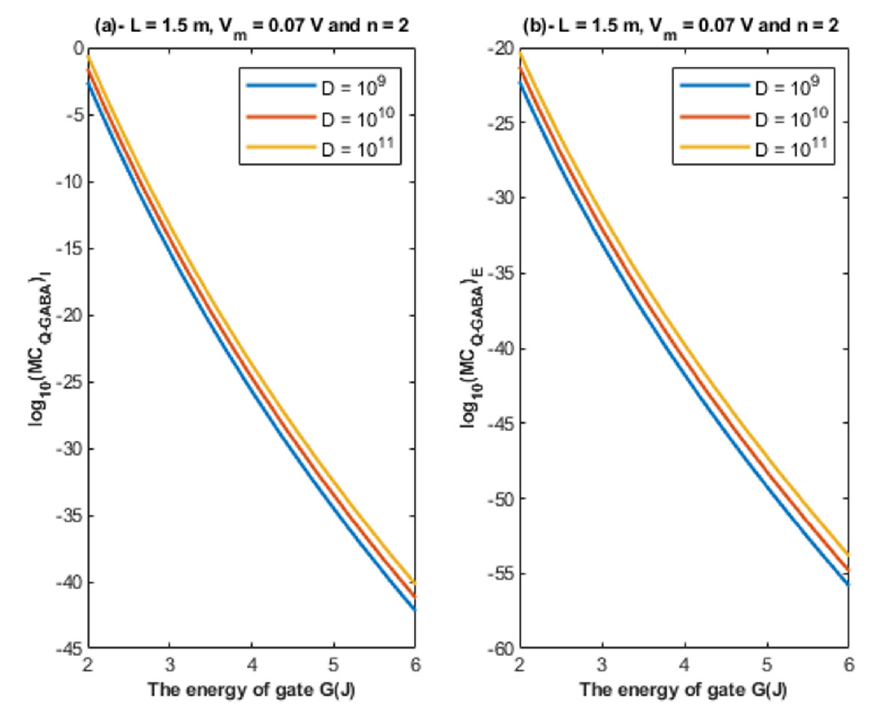
Figure 13. ( a , b ): The figure represents the relationship between the energy of gate G and the common logarithm of the quantum membrane conductance of the intracellular chloride ions log ( ) MC − and the quantum membrane conductance of the extracellular chloride ions 10 Q GABA I log ( ) MC − , respectively. The relationships are investigated at different values of 10 Q GABA E receptors density and according to the setting values above each graph.